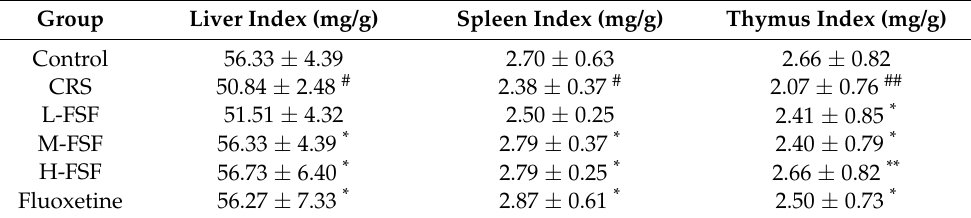
Table 3. Effects of FSF on the organ index in mice.